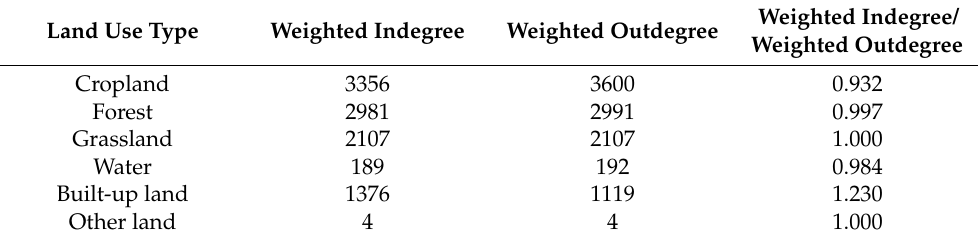
Table 8. Weighted indegree and weighted outdegree from